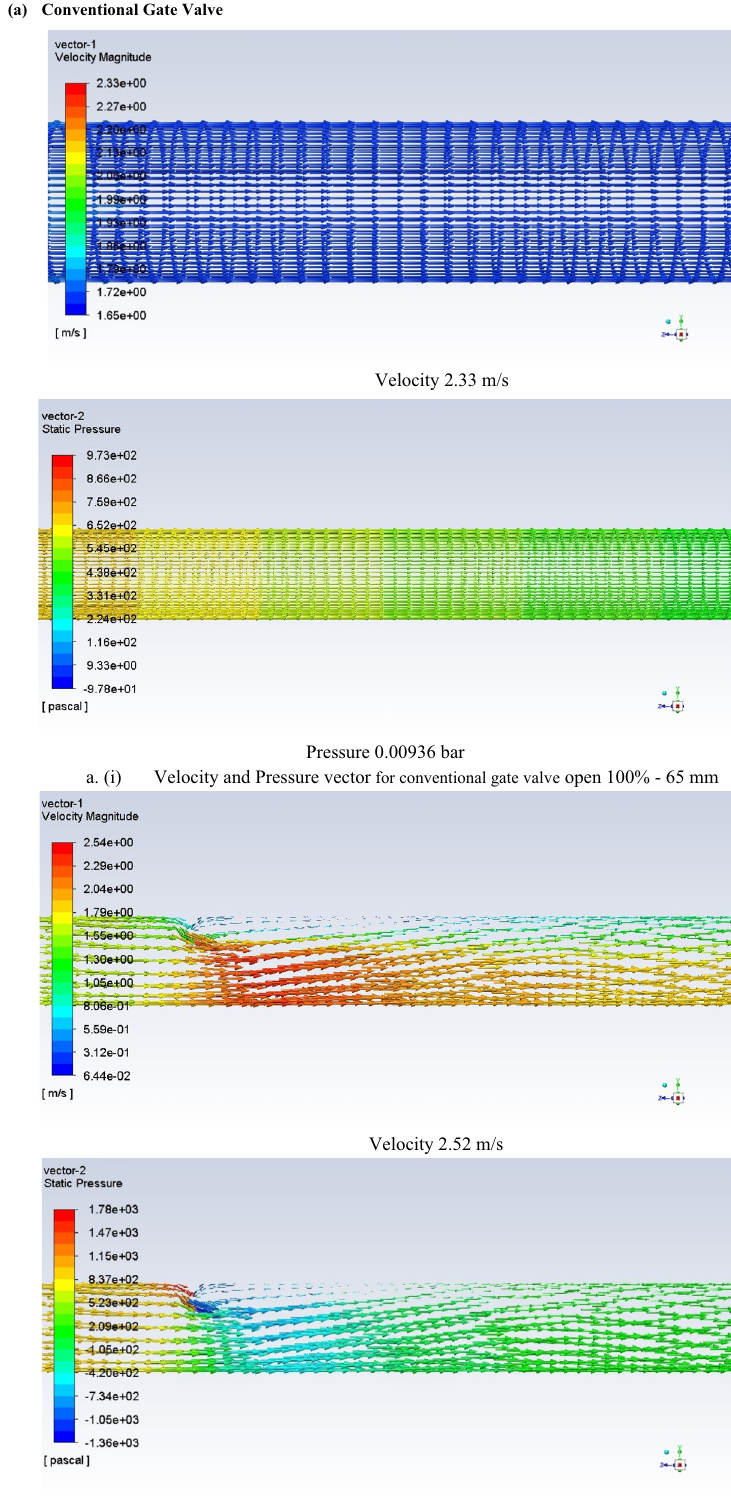
Fig. 12 Velocity and pres- sure vectors of water passing through pipe for ( a ) Conven- tional and ( b ) modified